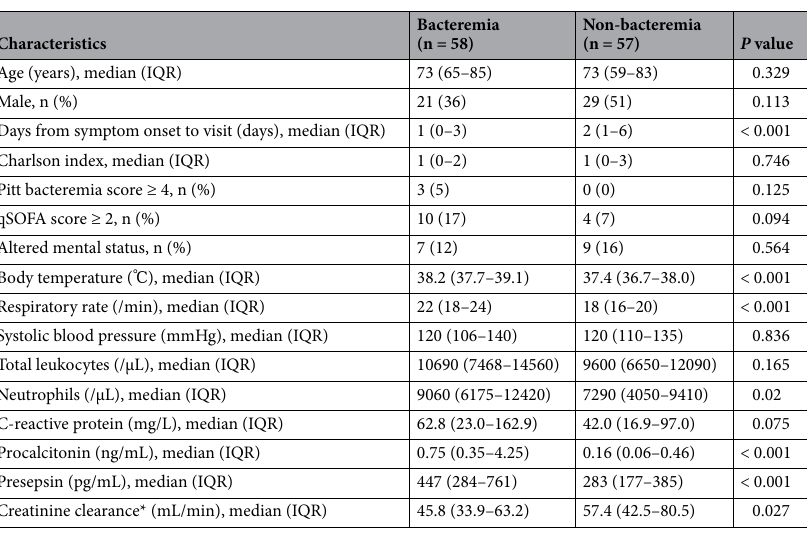
Table 1. Clinical characteristics of patients with bacteremia and without bacteremia (n = 115). IQR, interquartile range. *Predicted by Cockcroft-Gault